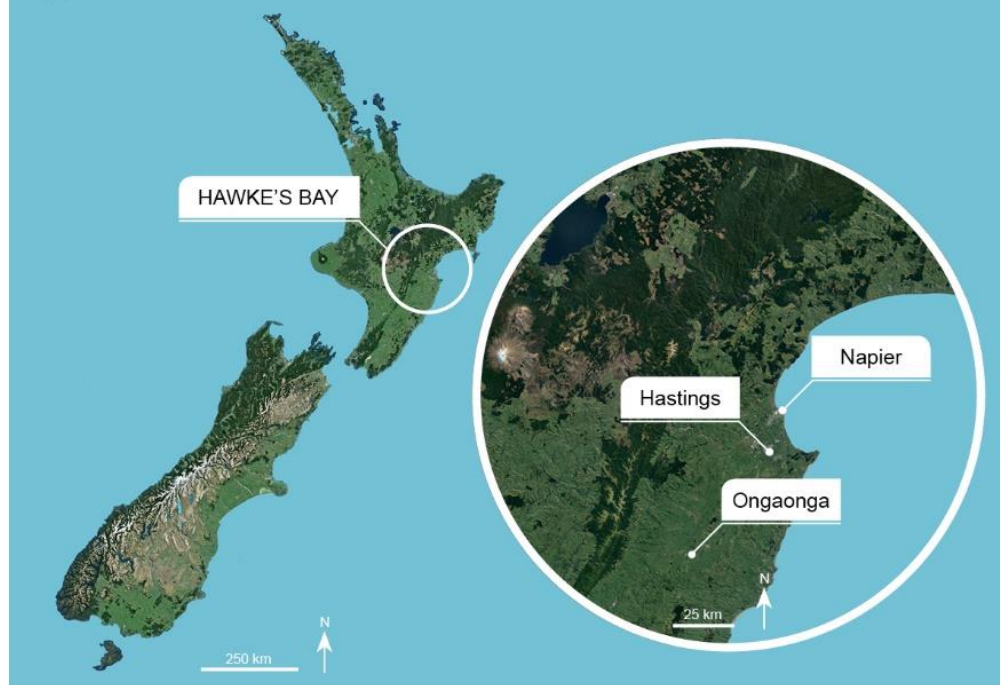
Figure 1. The location of Hawke’s Bay in New Zealand and the two study sites of Hastings on the Heretaunga Plains and Ongaonga in Central Hawke’s Bay. Map image courtesy Google Earth (accessed on 4 June 2019).